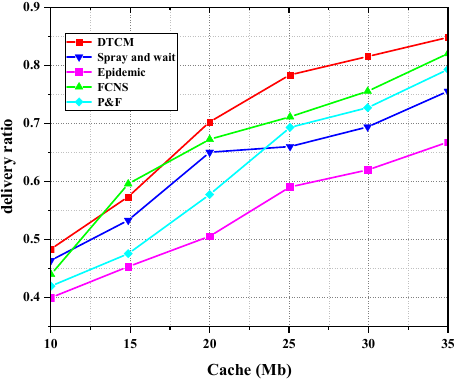
Figure 6. Delivery ratio comparison from five algorithms with various cache spaces.